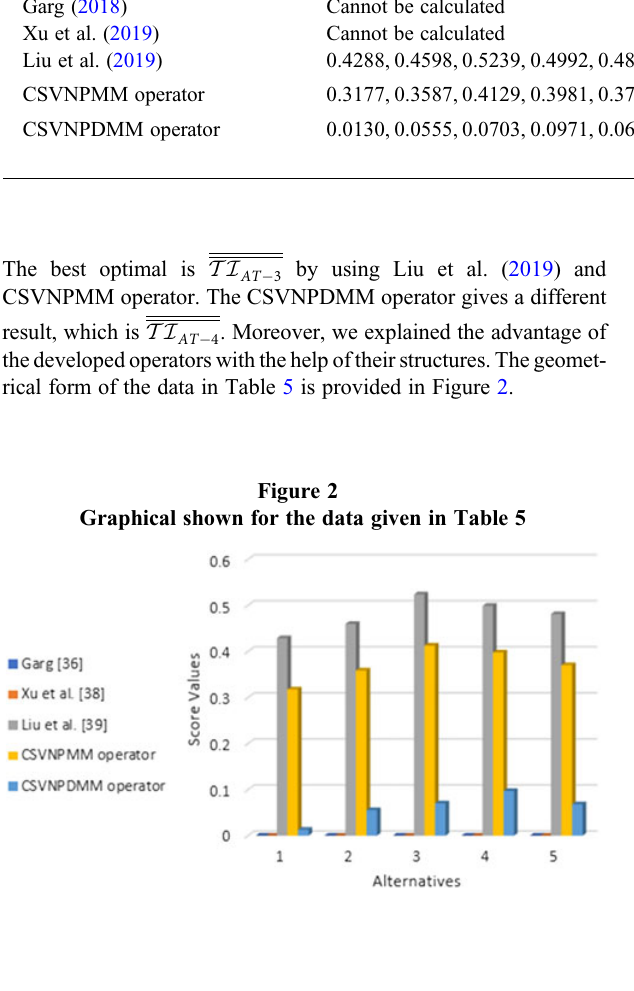
Expression of the comparative analysis for the information in Table 1 (without imaginary parts) Methods